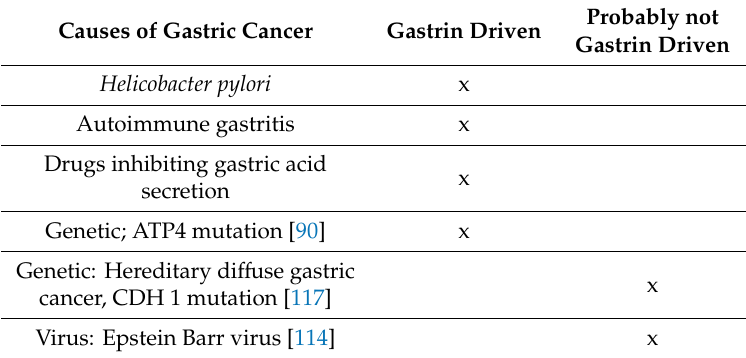
Table 2. Causes of gastric